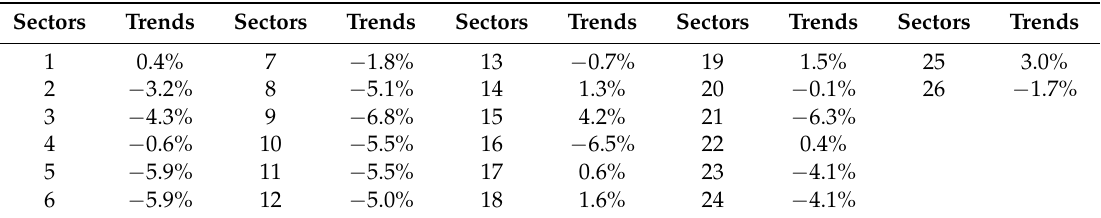
Table 5. Change trends of conversion coefficients of sectoral virtual grey water footprint under Grade III water quality standard from 2002 to 2012.